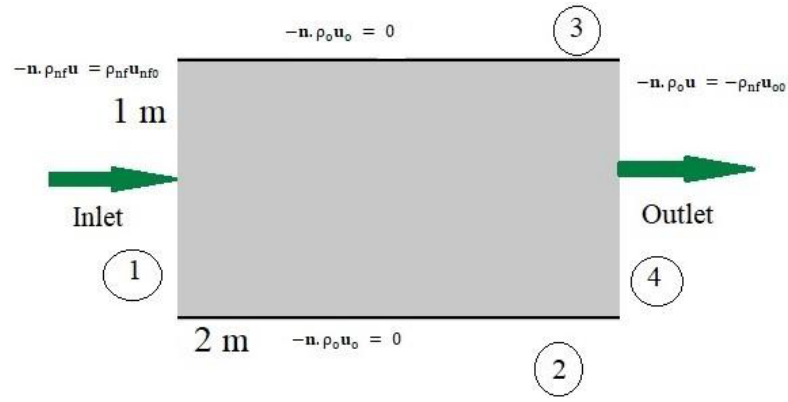
Figure 1. The planned pattern ’ s schematic geometry.